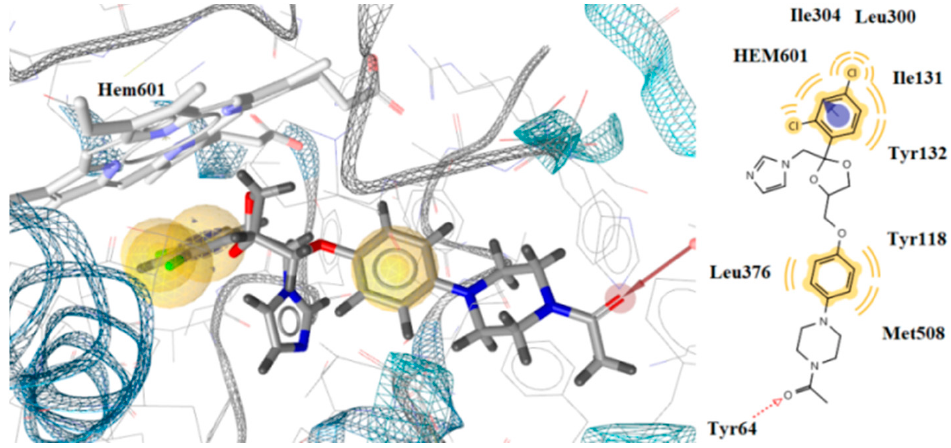
Figure 6. Docking of ketoconazole on CYP51of Candida albicans.